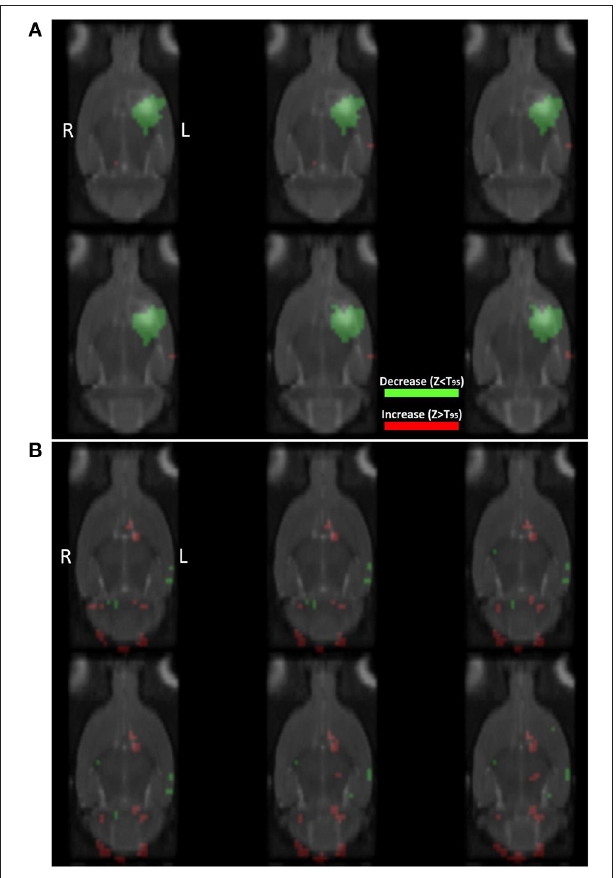
FIGURE 5 | Coronal slices showing the results of statistical analysis on the individual level by voxel-wise calculation of z-scores using (A) an ICH animal and (B) a control animal. T 95 : threshold based on the 95% confidence interval of Z -scores inside the brain. Red: significantly increased glucose uptake, green: significantly decreased glucose uptake compared to baseline. Colored regions are overlayed on the interpolated T2 templates of ICH and control animals at day 1 post-injection,